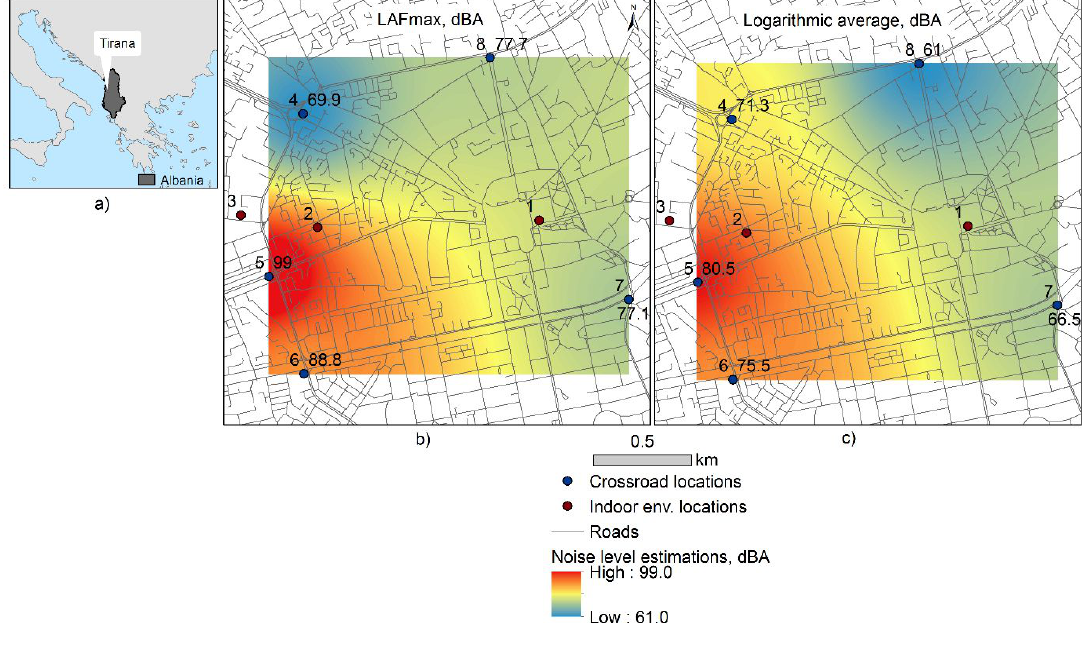
Figure 1: Map of Tirana and locations in indoor and outdoor environments: (a) location of Tirana and Albania, (b) the estimated LAF max , (c) the estimated logarithmic values of noise levels using Inverse Distance Weighted 3D (IDW3D). Indoor environment locations are indicated by one, two and three in red color. Outdoor environment locations are numbered four, five, six, seven and eight in blue color. Roads are provided by OpenStreetMap, for